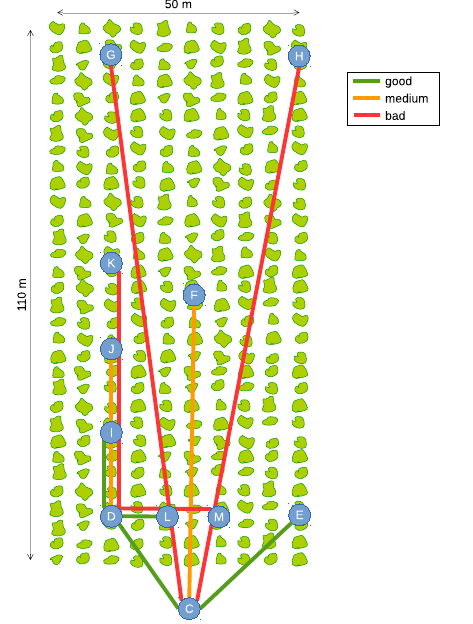
Figure 8. Locations for range testing in the orchard.